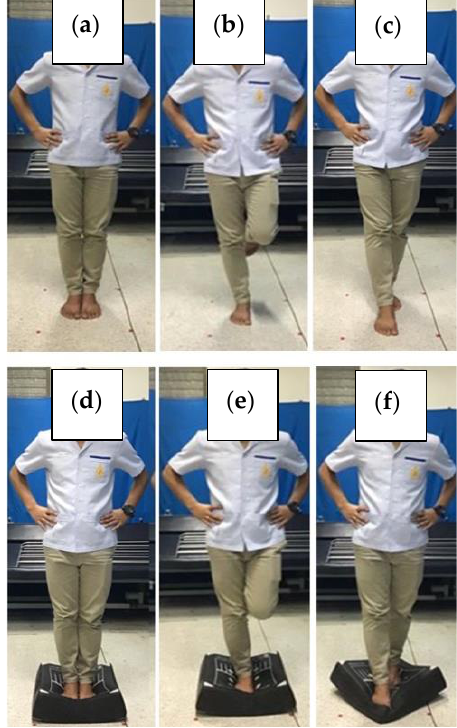
Figure 2. Static balance assessment. ( a ) Double leg stance with feet together (firm surface), ( b ) single leg stance on non-dominant foot (firm surface), ( c ) tandem stance on non-dominant foot in back (firm surface), ( d ) double leg stance with feet together (foam surface), ( e ) single leg stance on non-dominant foot (foam surface), and ( f ) tandem stance on non-dominant foot in back (foam surface).